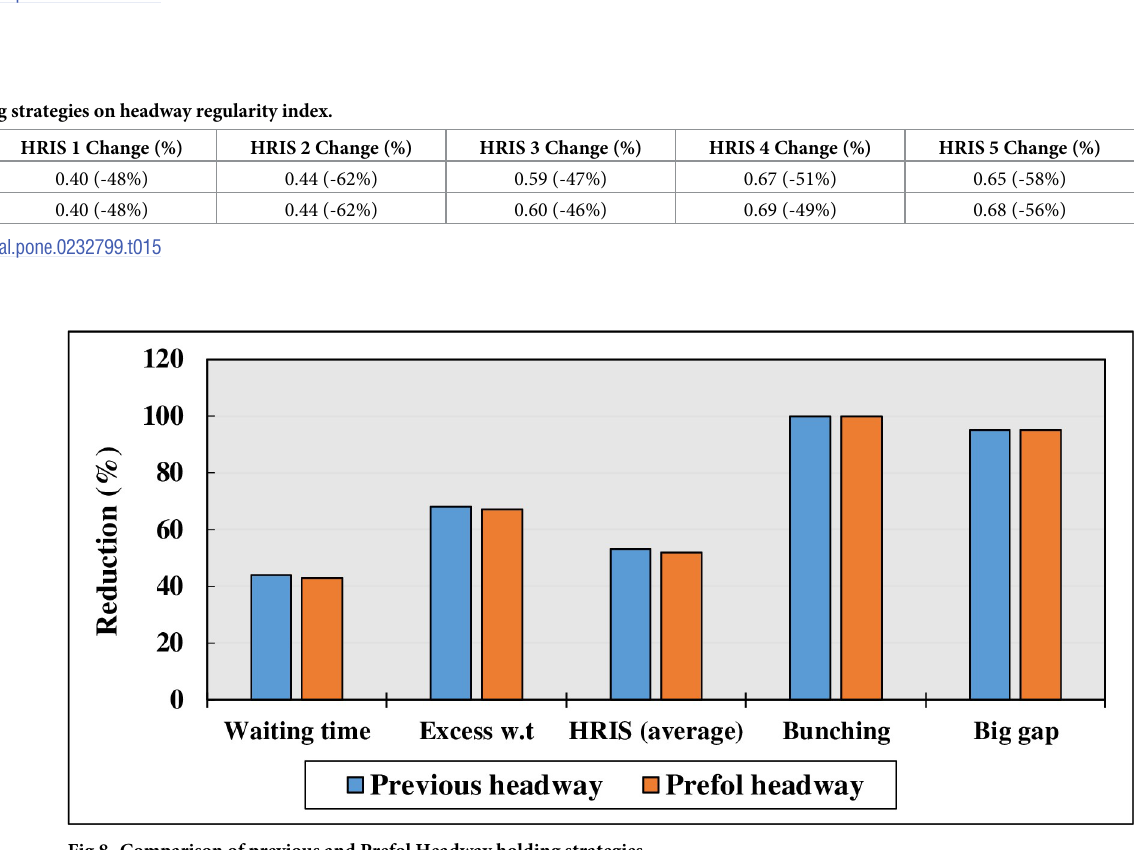
Fig 8. Comparison of previous and Prefol Headway holding strategies.